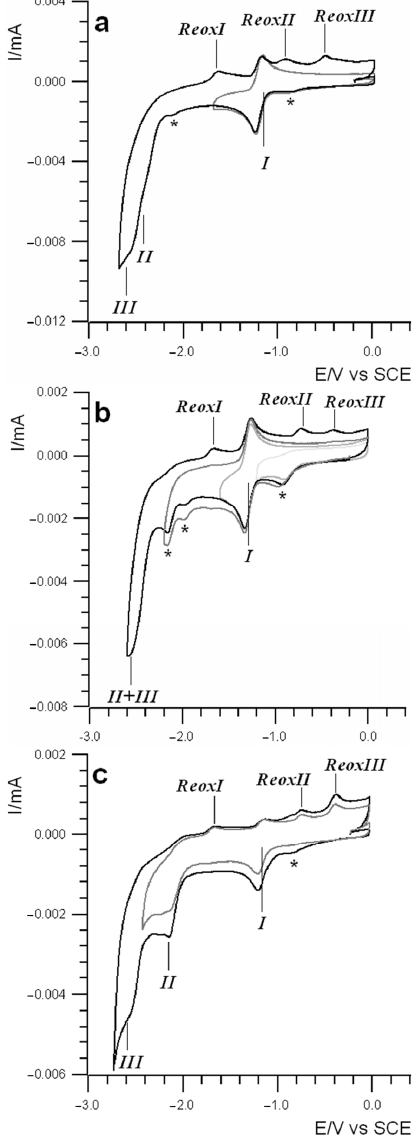
Figure 1. Cyclic voltammetry curves in Ar atmosphere of Mn-SMe ( a ), Mn-OMe ( b ), Mn-SPh ( c ). Solvent: DMF, scan rate: 0.4 V/s; T = 298 K. Reduction peaks indicated with * represent processes of unidentified decomposition products.